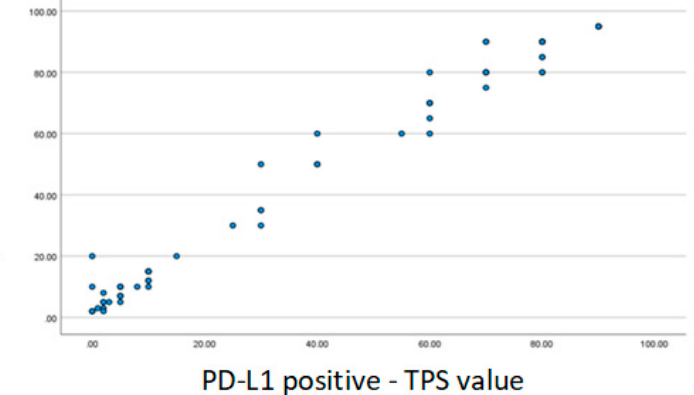
Figure 1. Scatter plot—Spearman correlation. PD-L1: programmed cell death ligand-1; TPS: tumor proportion score; CPS: combined positive score.